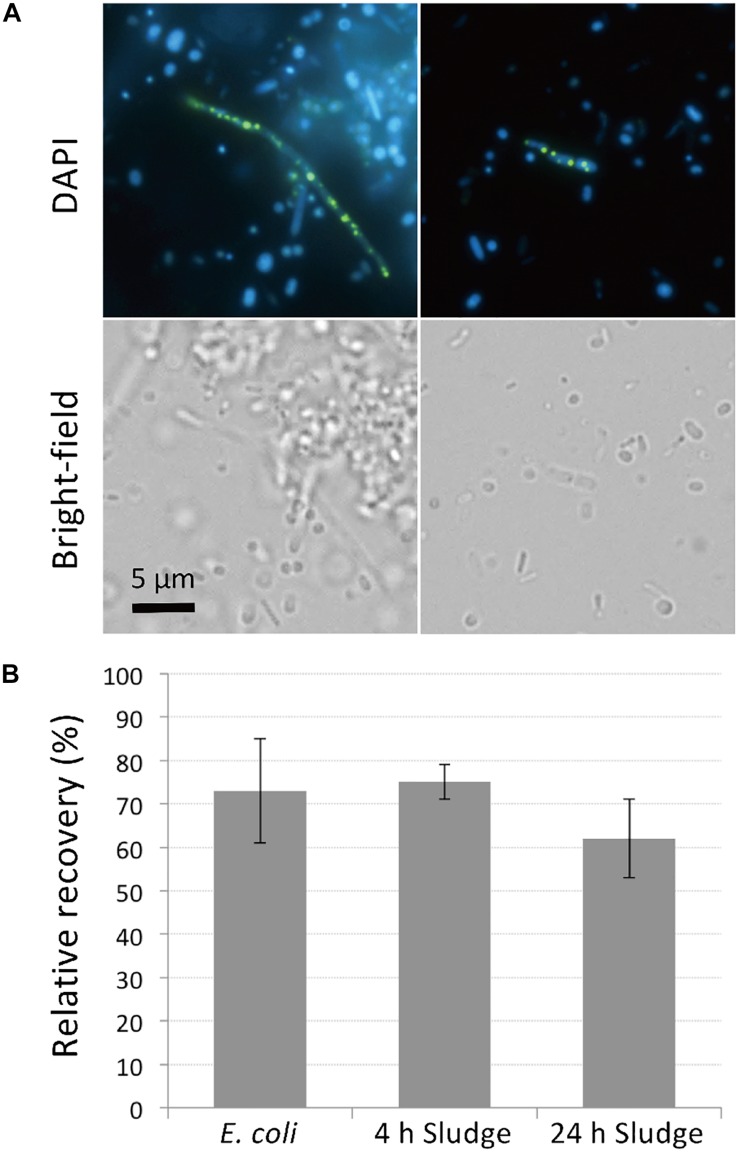
DAPI stains DNA and polyP while maintaining cell viability. (A) DAPI-stained images of sludge sample. Top panels show fluorescence images using DAPI filter and bottom panels show bright-field images. DNA emits a blue fluorescence and polyP emits green-yellow fluorescence. (B) Most cells recover and generate colonies after DAPI staining. Recovery rates were compared between DAPI-stained and unstained cells by colony counting. Here, the relative recovery rates (% recovery of DAPI-stained cells relative to unstained cells) are shown. Error bars indicate standard deviations of three replicate experiments.